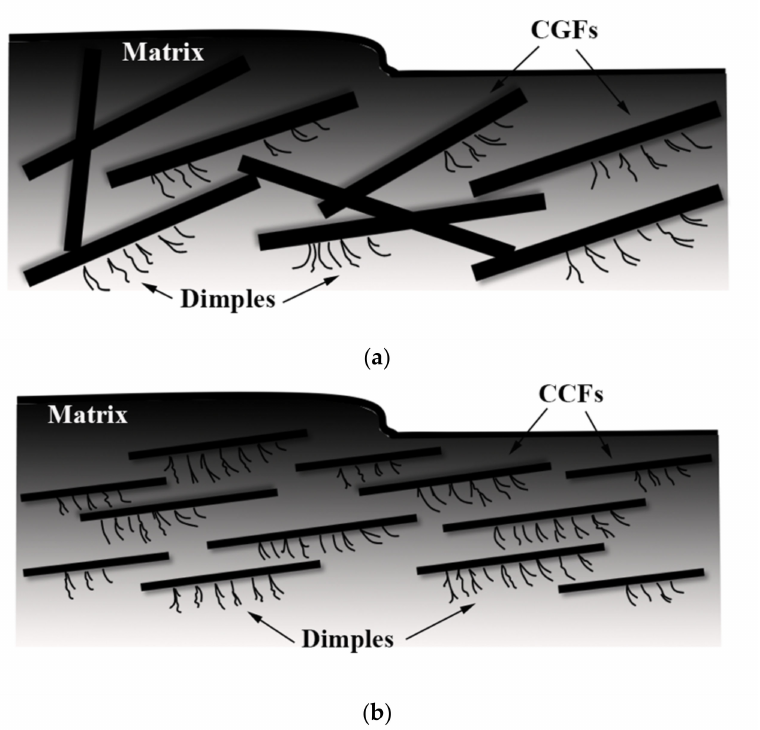
Figure 8. Schematic diagrams of “dimples” in ( a ) CGFR-LDUPR sample matrix and in ( b ) the CCFR-LDUPR sample